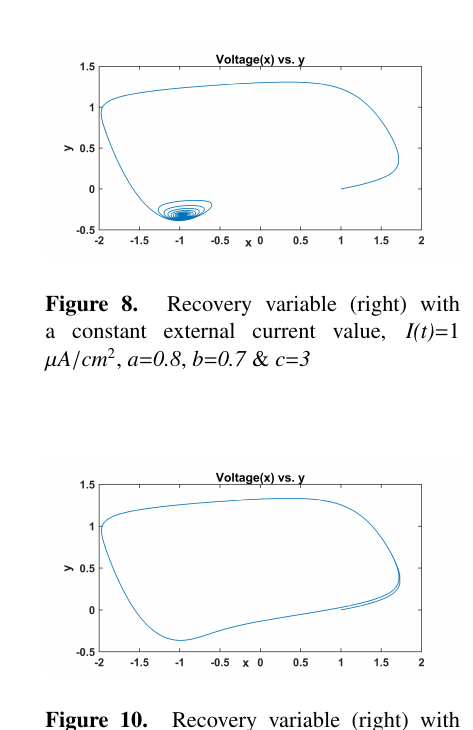
Figure 9. Responses of membrane potential with a constant external current value, I(t) = 1.1 µ A / cm 2 , a = 0.8 , b = 0.7 & c = 3